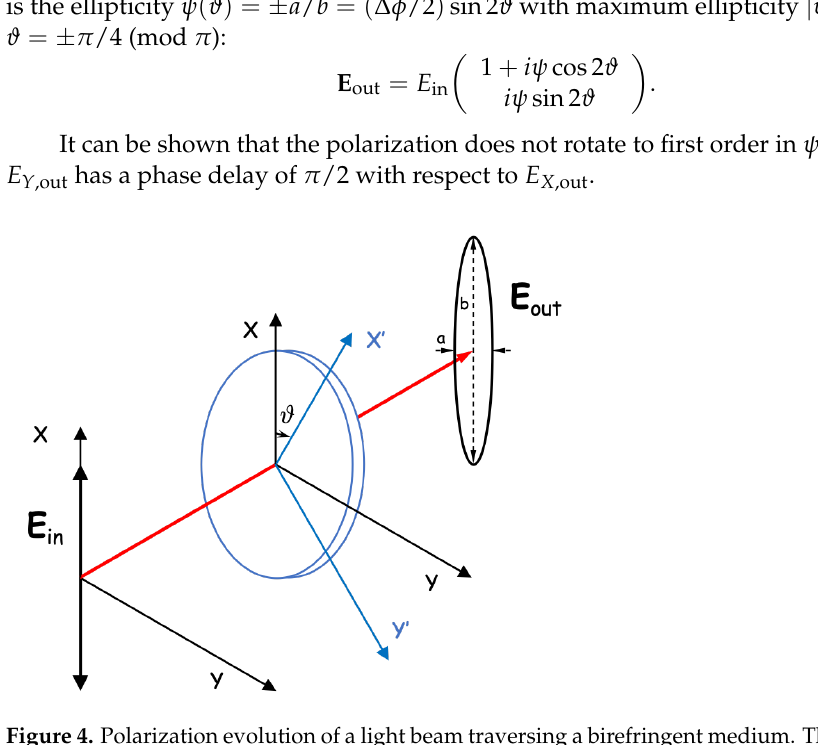
Figure 4. Polarization evolution of a light beam traversing a birefringent medium. The XYZ reference frame is defined by the initial polarization vector E in and the wave-vector k . The rotated axes X (cid:48) Y (cid:48) Z coincide with the birefringence axes of the optical